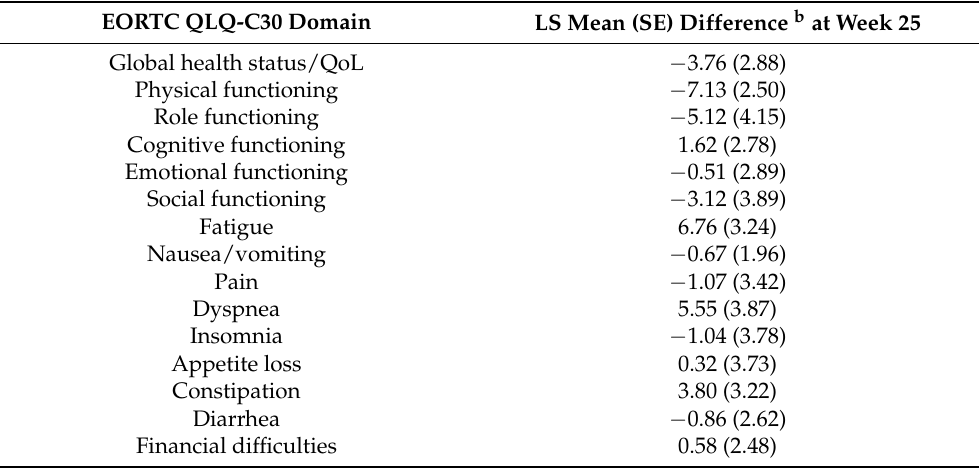
Table 3. LS mean difference in change in EORTC QLQ-C30 domain scores from baseline to week 25 between luspatercept + BSC and placebo + BSC a